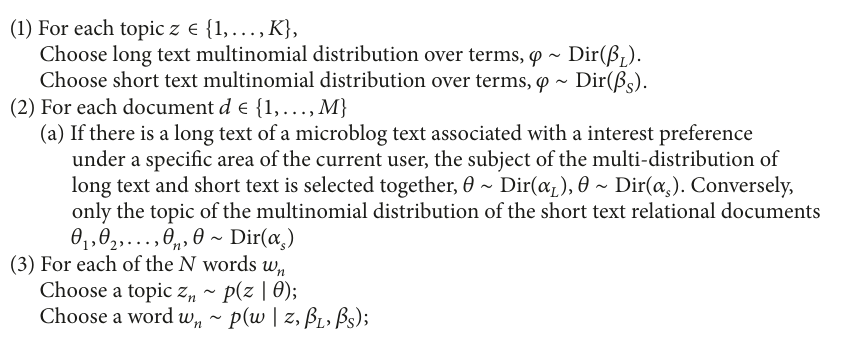
Algorithm 2: The generation process of CLDA.